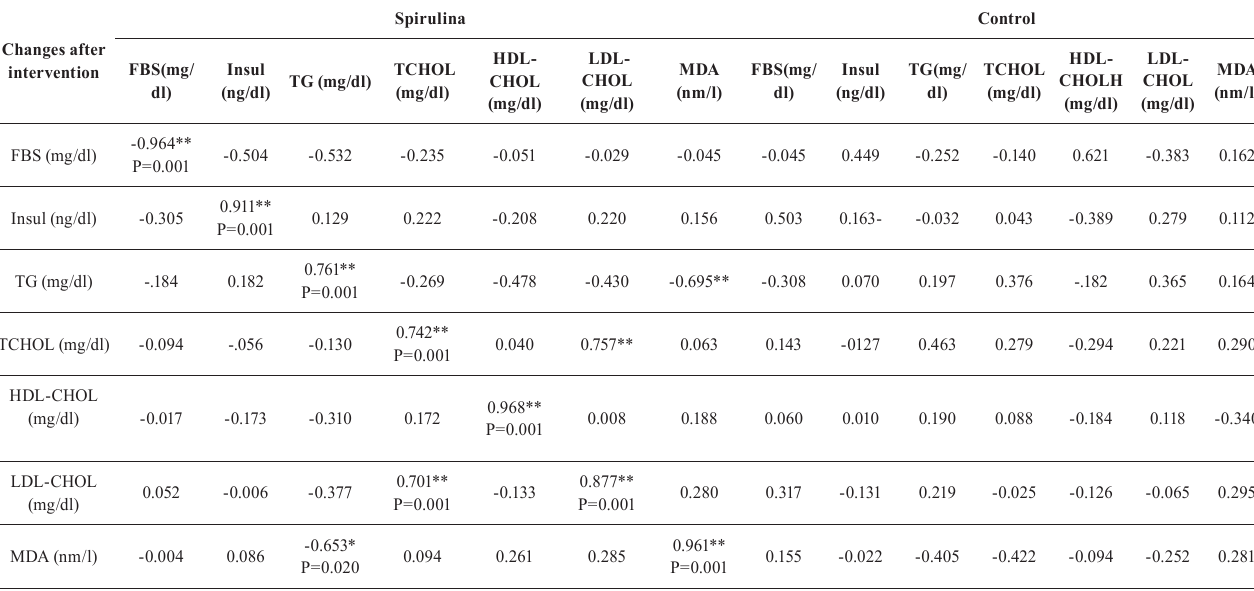
FBS: Fasting blood glucose, Insulin: insul., TG: Triglyceride, TCHOL.: Total-cholesterol, HDL-CHOL.: High density lipoprotein-cholesterol, LDL-CHOL.: Low density lipoprotein -cholesterol, MDA: